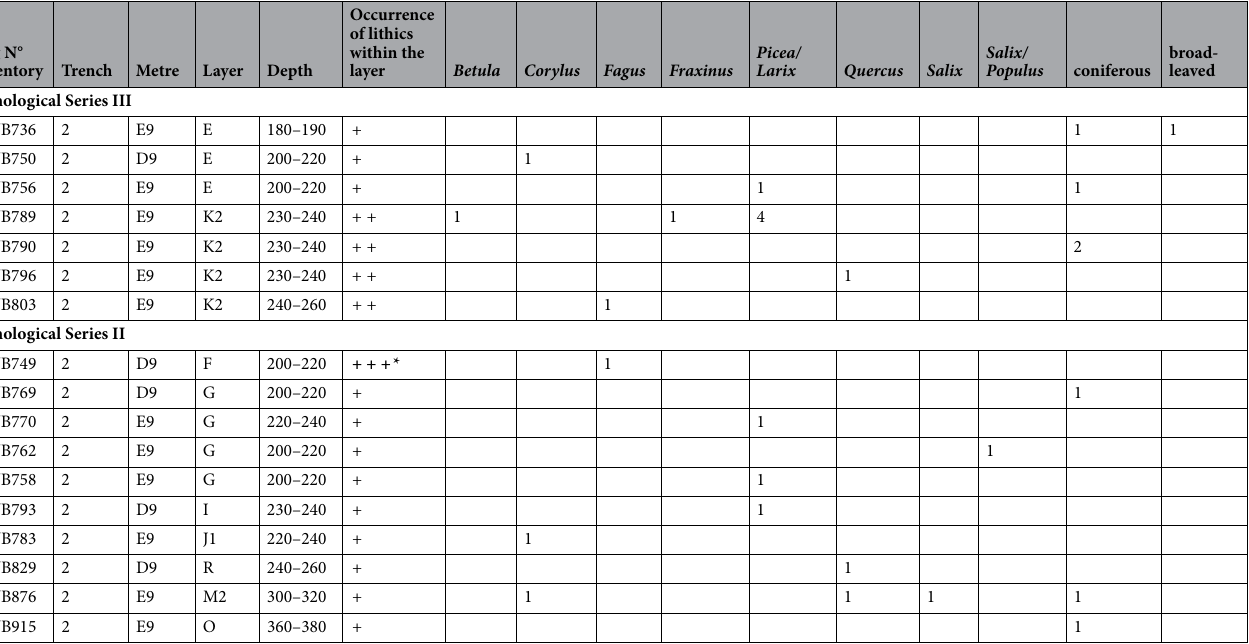
Table 1. Results of wood charcoal analysis from lithological Series II and III from Tunel Wielki Cave. *The burned